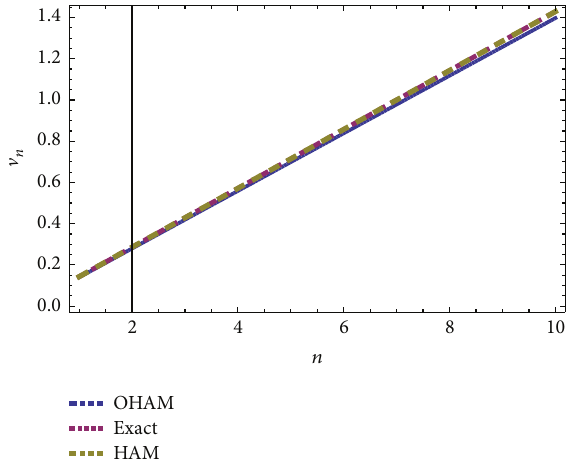
Figure 3: Comparisons of OHAM, HAM and exact solutions at 𝑡 = 1 , ℎ = −1 .